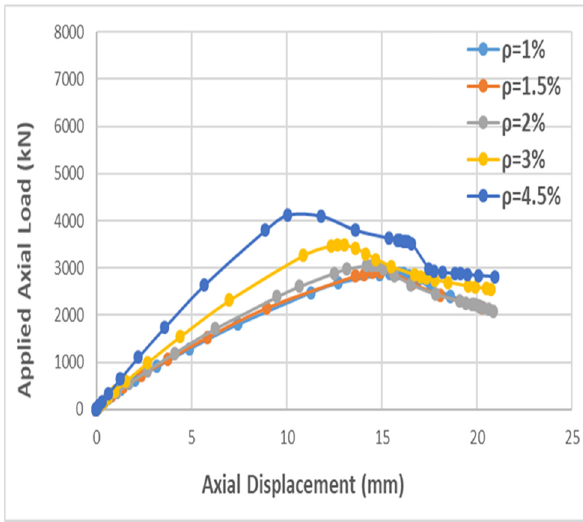
Figure 8: Numerical load - axial deformation of RC column with dif - ferent reinforcement ratios after heating at 600°C.